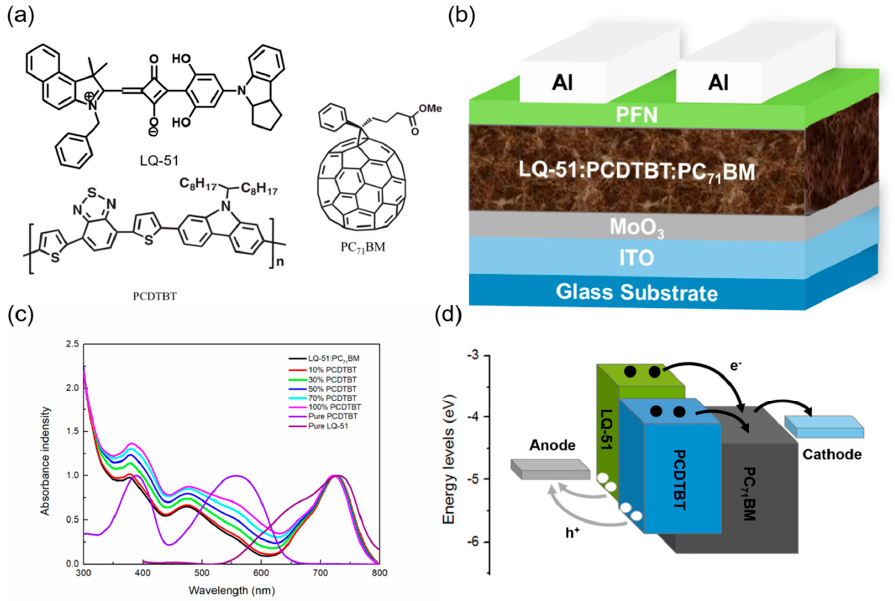
Figure 1. Material properties and device structure. ( a ) Chemical structures of LQ-51, PCDTBT, and PC 71 BM used in here; ( b ) Device architecture of organic solar cells; ( c ) The absorption spectra of binary and ternary films with different PCDTBT incorporation concentration; ( d ) The energy level diagram and proposed charge carrier transport paths in the